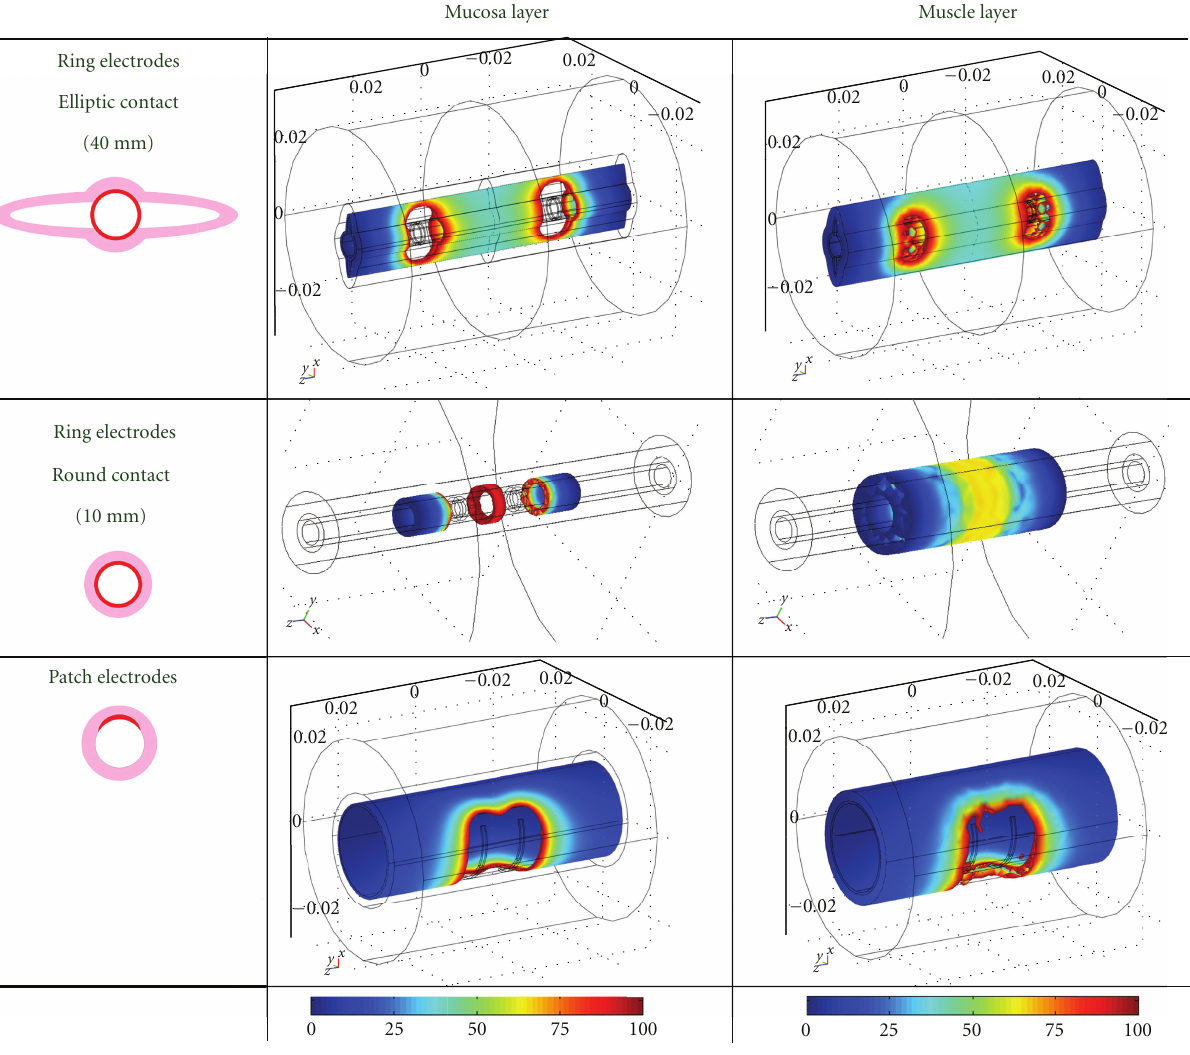
Figure 2: Color-coded graphs of the voltage distribution for the mucosa and the muscle layers computed using FEM. The range of colors from blue to red represents the range from 0 to 100 V/m. The current I was in all cases 20mA. The first column illustrates the geometry of di ff erent contact between electrodes and mucosa. The upper row of graphs is obtained from ring electrodes and an elliptical contact area with the mucosa. The middle graphs are obtained from ring electrodes with a circular contact area to the esophageal mucosa. The bottom graphs are obtained from patch electrodes in contact with the